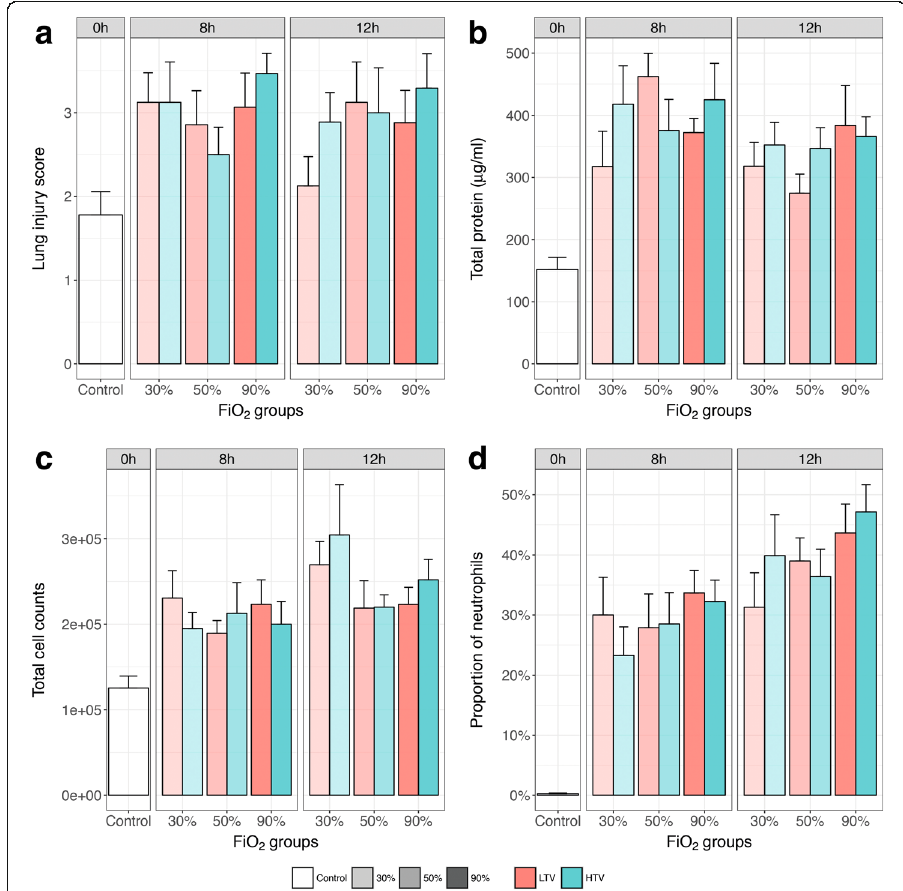
Fig. 2 Markers of lung injury in BALf after indicated study interval. Data are means ± SEM. Lung injury score ( a , upper left panel), total protein content ( b , uppe r right panel), total cell counts ( c , lower left panel), and proportion of neutrophils ( d , lower right panel) in BALf obtained after the study interval. Facets within the panels represent mechanical ventilation time. Different colors represent different tidal volume groups, and different transparency levels represent different FiO 2 groups. 0h no mechanical ventilation time, control group; 8h 8 h of mechanical ventilation, 12h 12 h of mechanical ventilation, LTV low tidal volumes, HTV high tidal